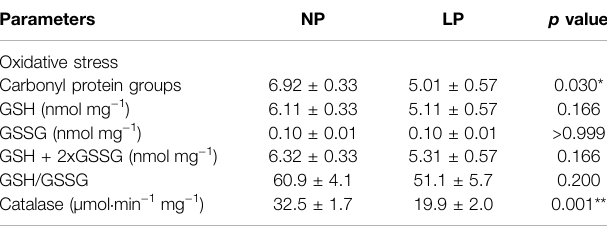
TABLE 6 | Oxidative Stress and receptor protein abundance in Heart. Parameters